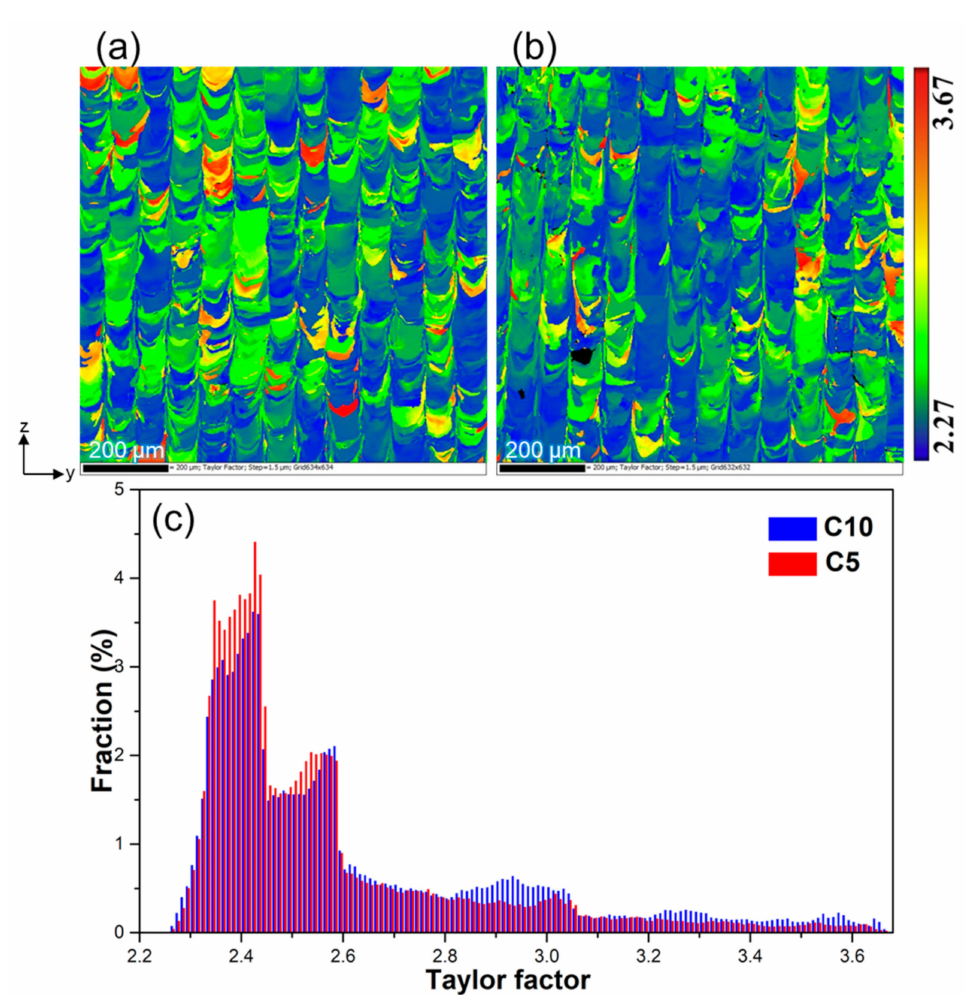
Figure 9. Taylor factor maps of as-built Cr components with ( a ) long scan length (C10) and ( b ) short scan length (C5). ( c ) The distribution of the Taylor factor of C10 and C5